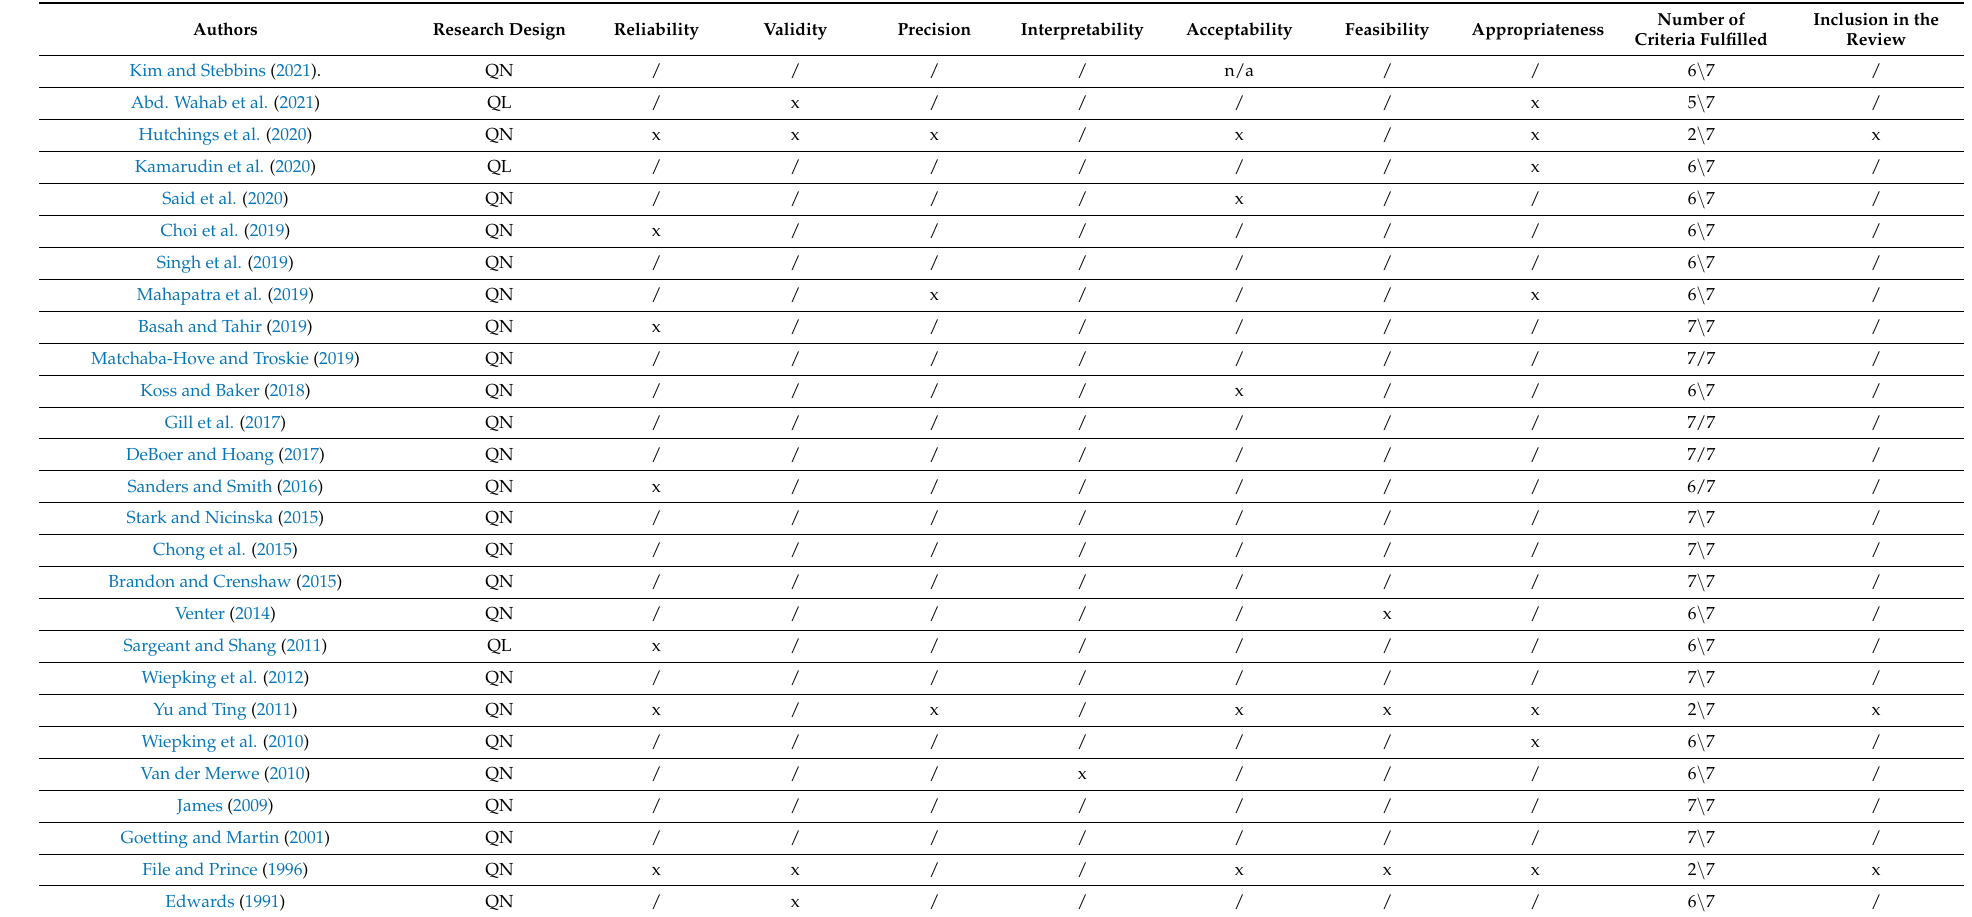
Table 4. Quality appraisal based on The Fitzpatrick Criteria for evaluating measurement